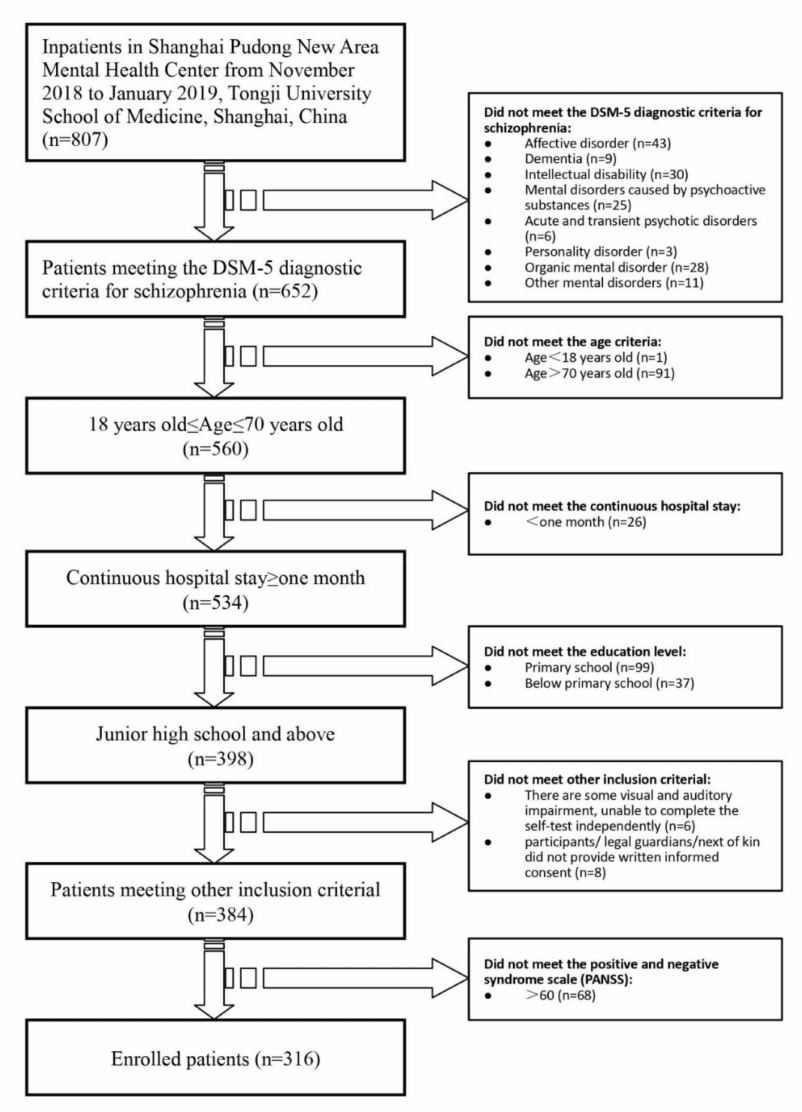
Figure 1. A cross-sectional study path